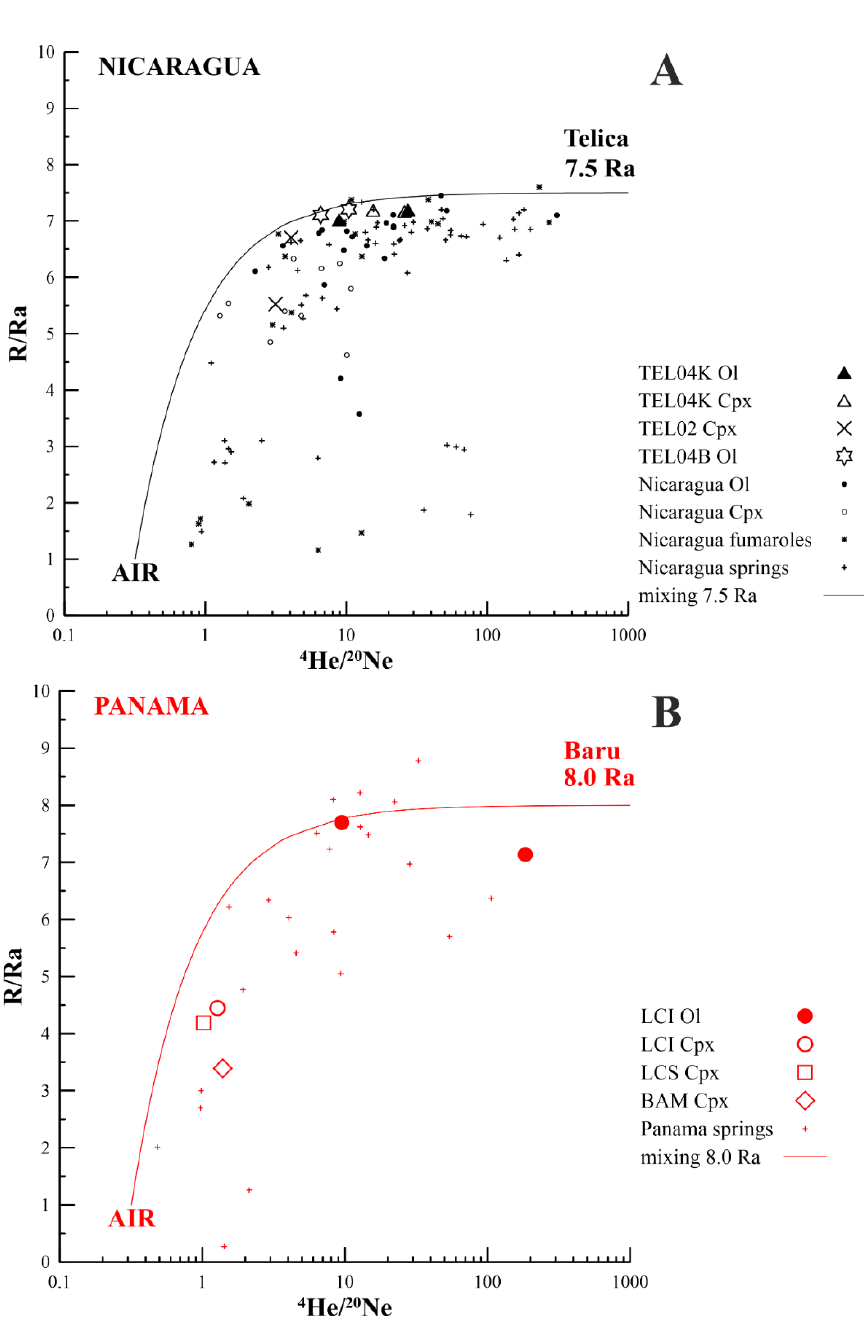
Figure 3. 4 He/ 20 Ne versus 3 He/ 4 He (R/Ra) in FI, fumaroles and springs from Nicaraguan ( A ) and Panamanian ( B ) segments of CAVA. Fumarole and springs data from previous studies are reported for comparison [27–30,34,38,42,45,48,54–61]. More details on the source data are reported in Supplementary Table S3. The black and red lines indicate binary mixing between air and two hypothetical magmatic/mantle sources assumed below the respective segments of CAVA.